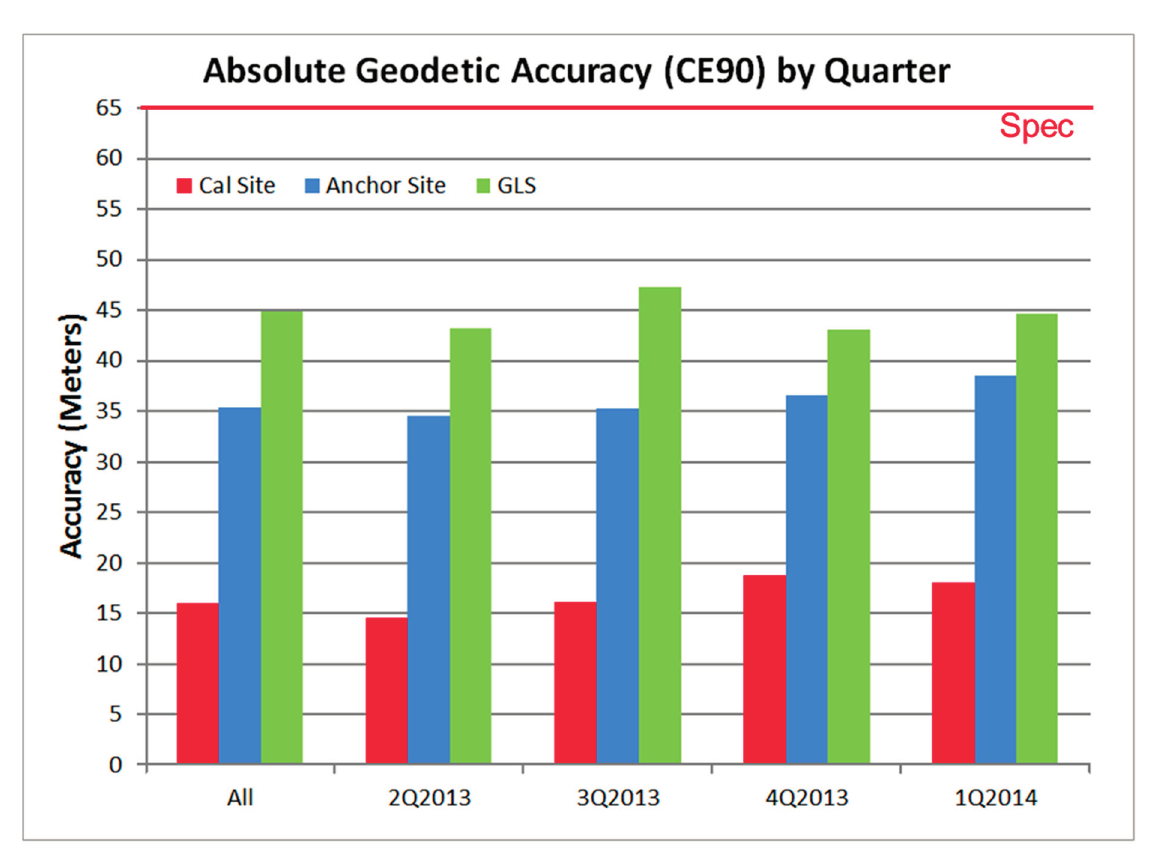
Figure 8. OLI absolute geodetic/geolocation accuracy by calendar quarter. Anchor sites are the subset of Global Land Survey (GLS) scenes that contained control points provided by the National Geospatial Intelligence Agency